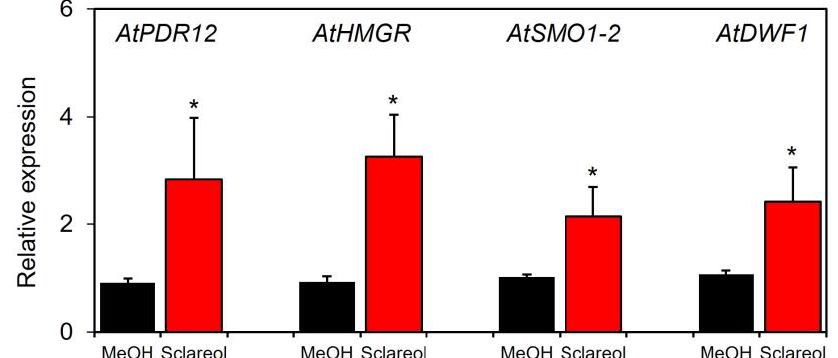
Figure 5. Effects of exogenous sclareol on the expression of phytosterol biosynthetic genes in Arabidopsis leaves. Arabidopsis plants were treated by soaking their roots in a solution containing 100 μ M sclareol for 48 h. The leaves of the treated plants were collected and subjected to a quantitative real-time PCR analysis. As a control, 0.1% methanol (MeOH) was used. Values are the means ± standard deviation of three biological replicates. Asterisks denote significant differences from the control (0.1% methanol) sample ( t -test, * p < 0.05). The experiment was repeated three times with similar results.